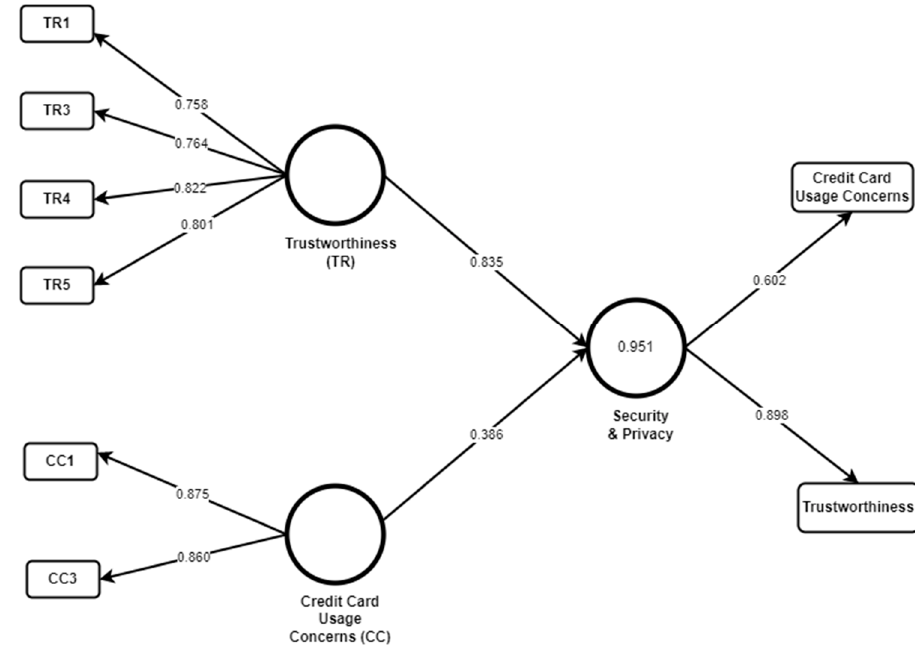
Figure 8. SHEIN model.